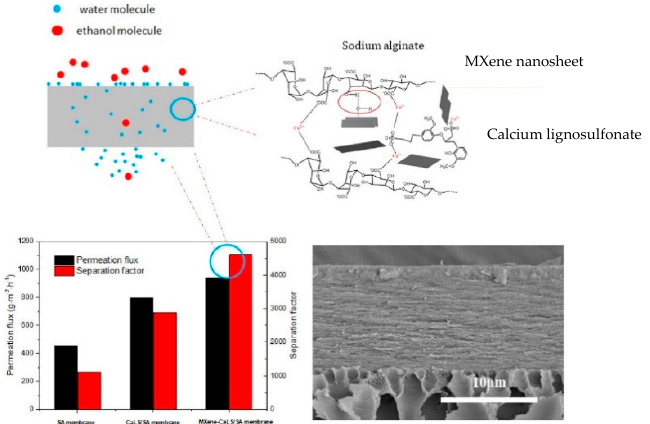
Figure 21. Hydrophilic calcium lignosulfonate combined with 2D-MXene, jointly modified the polysaccharide sodium alginate.